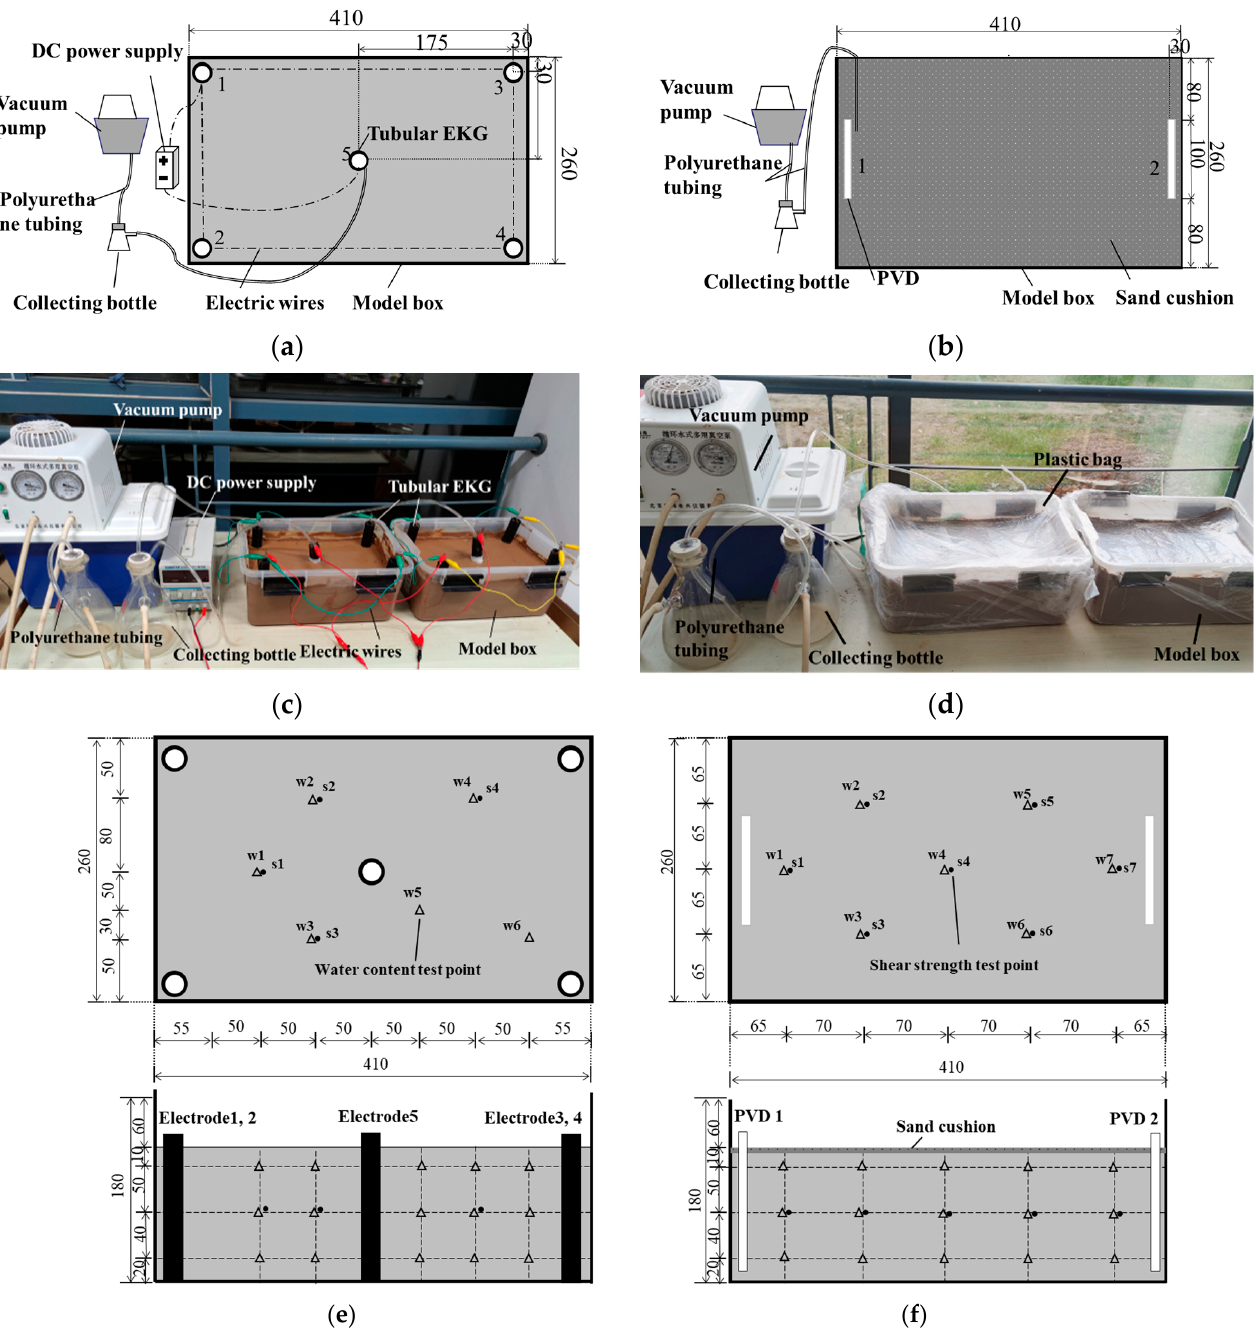
Figure 3. Schematic configuration: ( a ) structure plan graph of EO test, ( b ) structure plan graph of VP test, ( c ) physical picture of EO test, ( d ) physical picture of VP test, ( e ) top view and side view of test points in EO test, and ( f ) top view and side view of test points in VP test (unit mm).